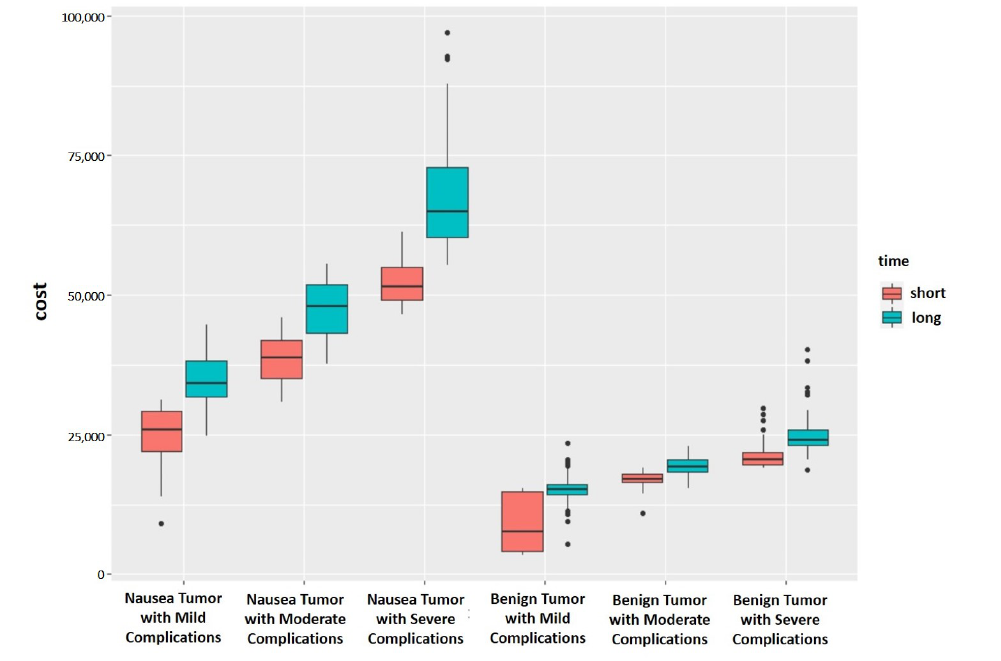
Figure 5. Differences in medical expenses among different groups. Table 3. Payment standard for ovarian cancer